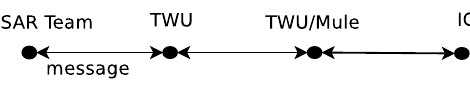
Figure 10. Message propagation